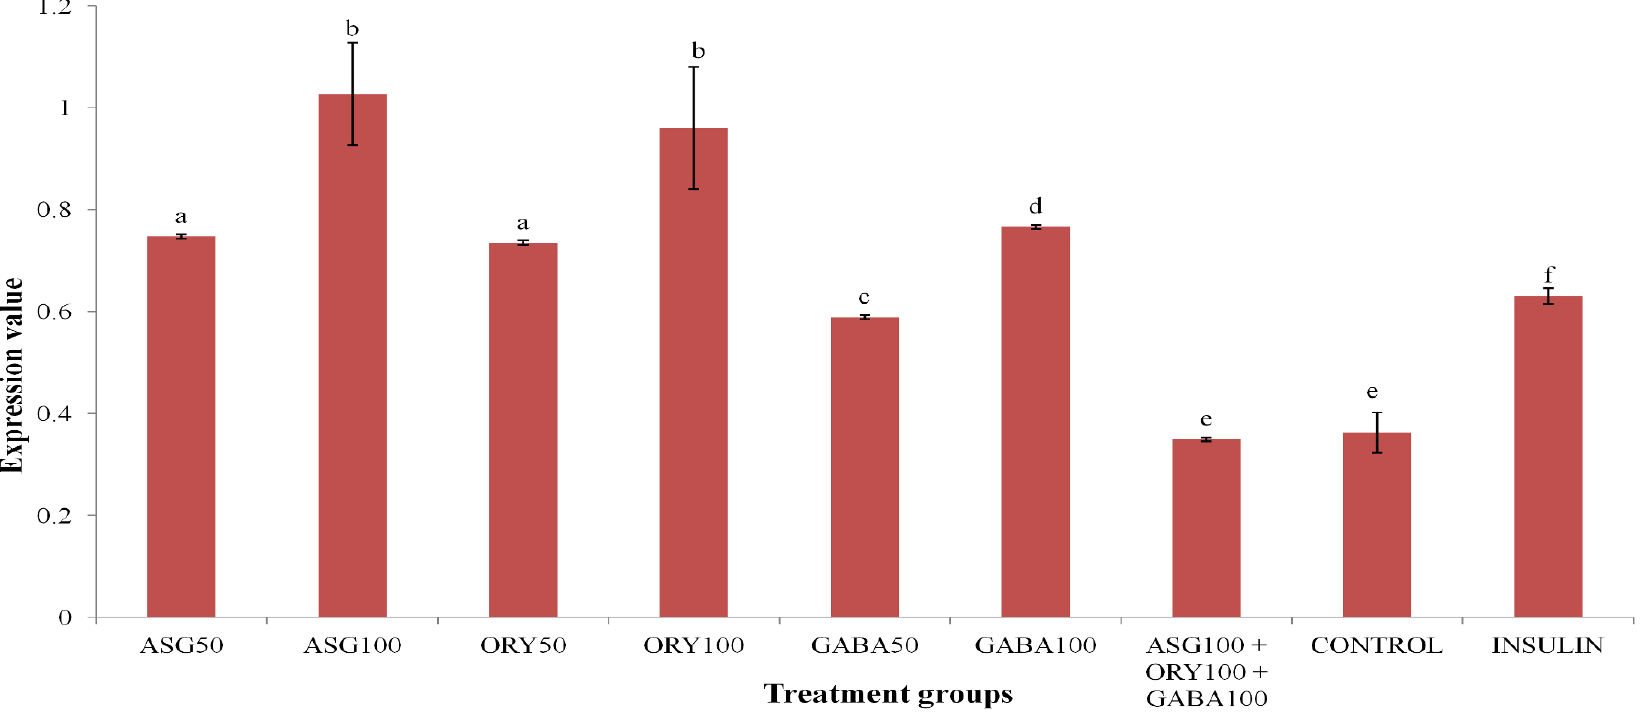
Figure 2. Expression of HEP-G2 peroxisome proliferator-activated receptor gamma ( PPARγ ) gene; treatment of HEP-G2 cells with 50 ppm and 100 ppm of extracts showed upregulation of the gene, above normal (insulin) and control, to varying degrees. All extracts significantly upregulated the expression of the gene in comparison to control ( p < 0.05) in a dose-dependent manner ( n = 4), but when combined (100 ppm), they downregulated the gene. Bars with different letters are significantly different ( p < 0.05). ASG-acylated steryl glycoside, ORY-oryzanol, GABA-gamma aminobutyric